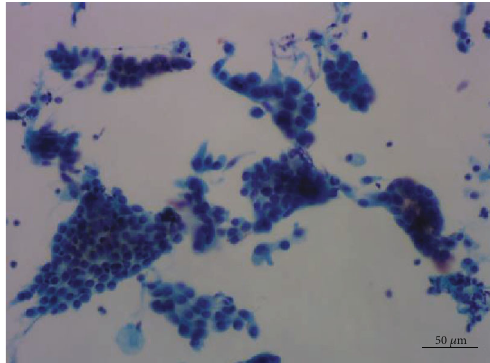
Figure 4: Thinprep Cytologic Test of papillary adenoma showed that the cells were arranged in fl at sheets, and some cells had larger nuclei. Pap staining, × 200.